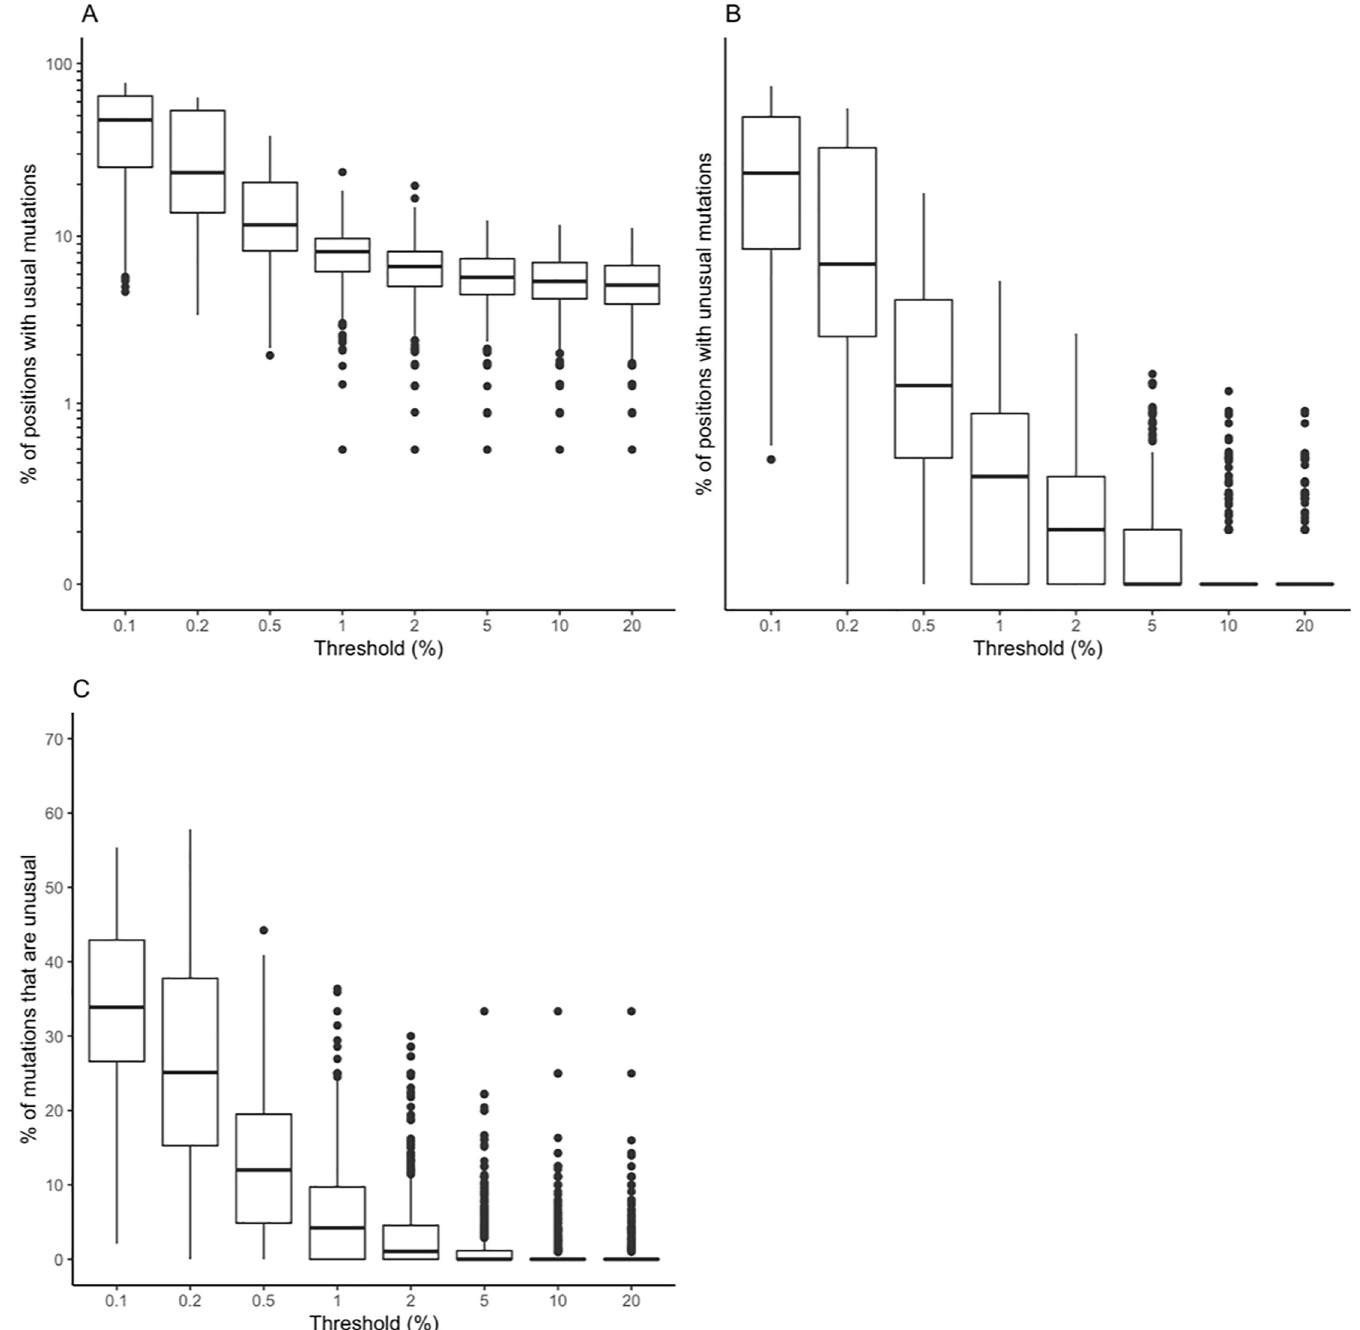
Fig 2. Boxplots demonstrating the distribution in the the proportion of positions with usual mutations (A), the proportion of positions with unusual mutations (B), and the proportion of mutations that were unusual (number of unusual mutations / [number of usual mutations + number of unusual mutations]) (C) at eight NGS mutation detection thresholds for pooled samples (n = 855) from eight published